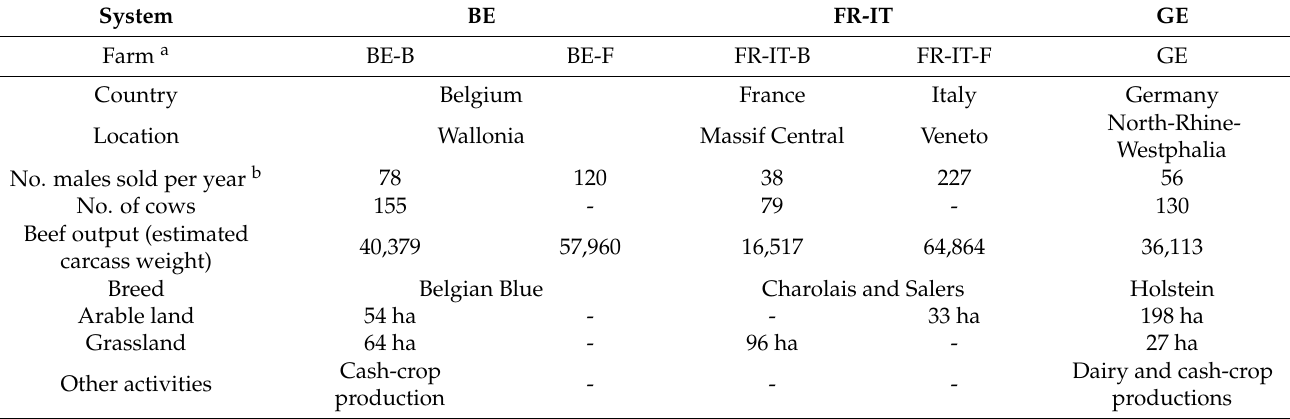
Table 1. Overview of the baseline beef production systems